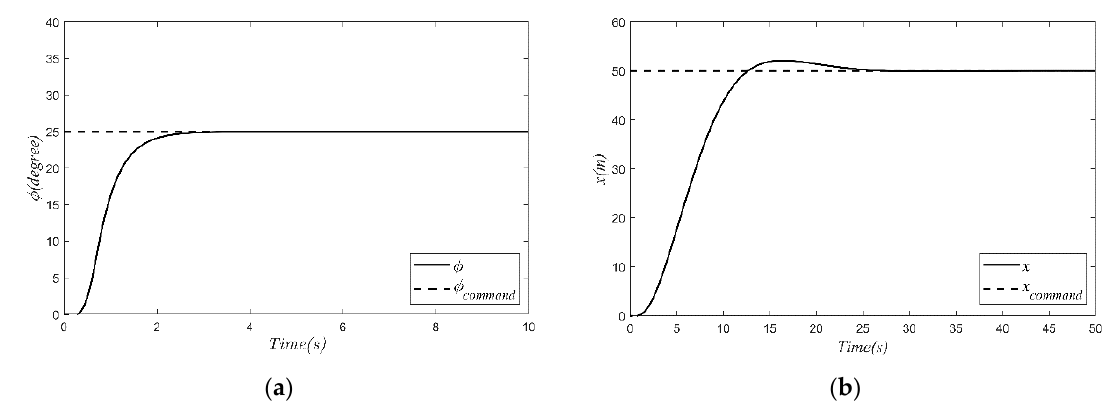
Figure 14. Schematic diagram of UAV and desired flight path.